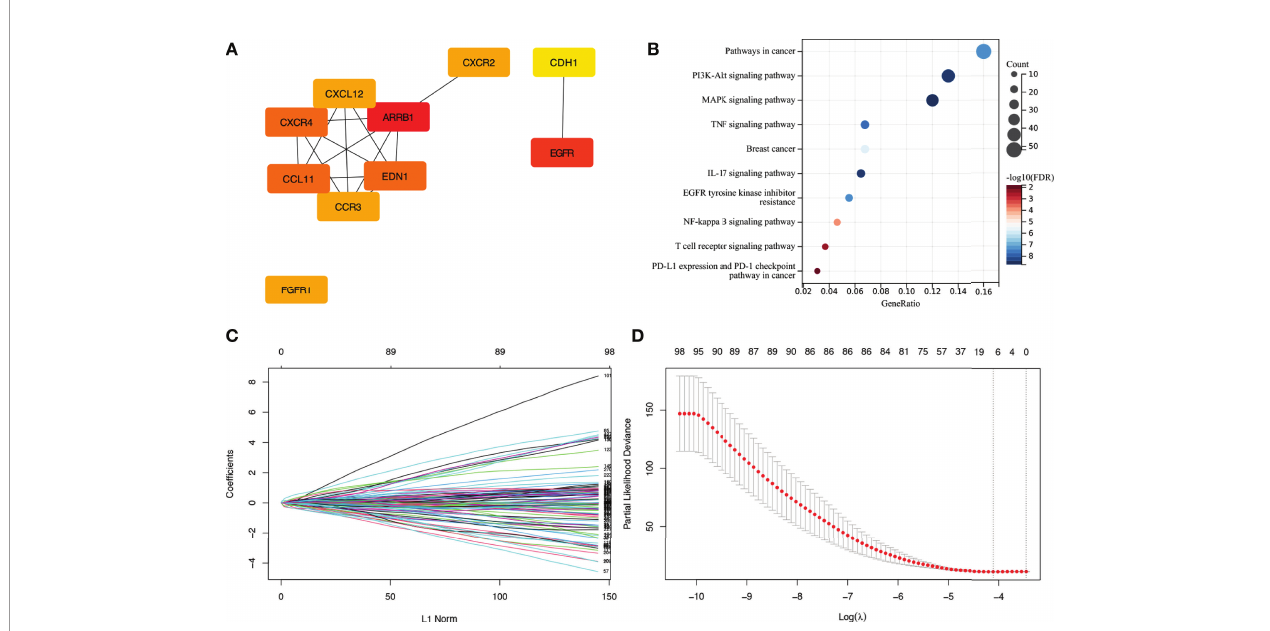
FIGURE 3 | Enrichment analysis of IRGs and LASSO cox regression analysis. (A) Display of hub genes in IRGs. (B) Pathways for IRGs enrichment. (C, D) Coef fi cients and partial likelihood deviance of LASSO cox regression analysis. IRG, immune-related